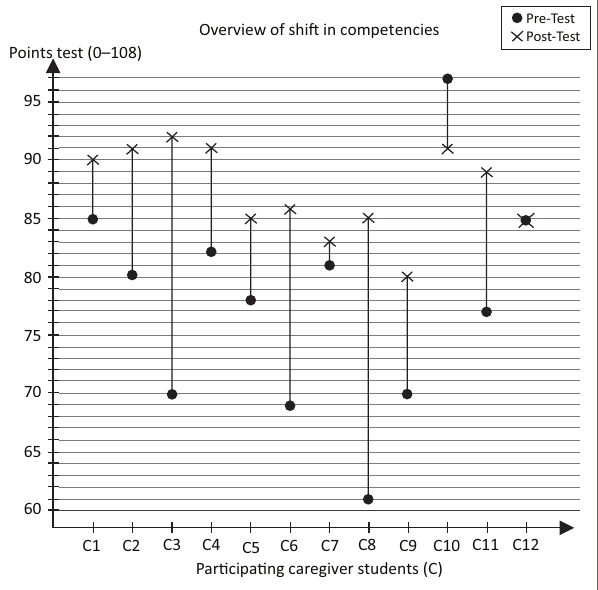
FIGURE 5: Overview of shift in competencies (TRC and MRC) of the 12 caregiver students